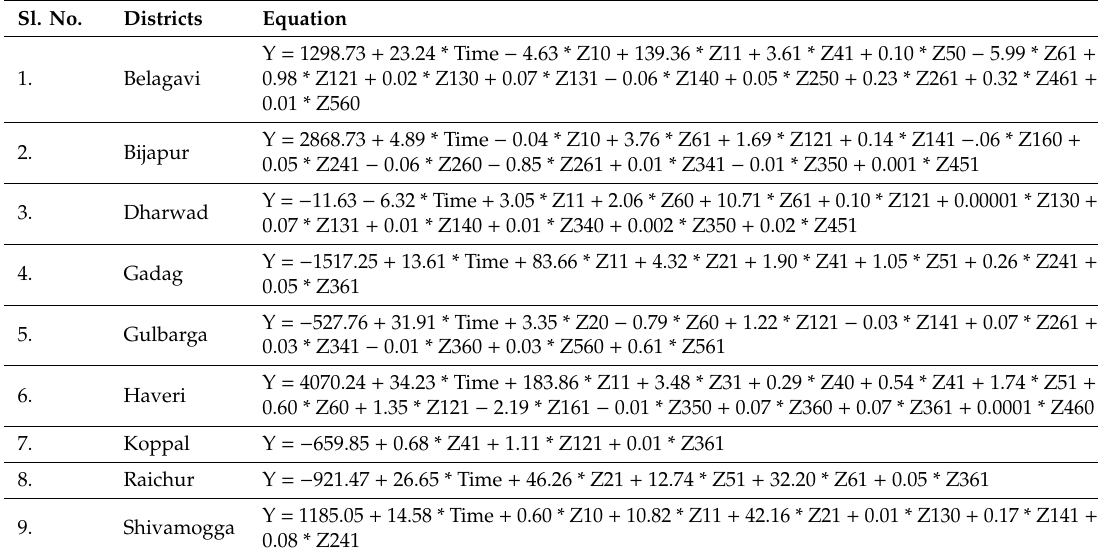
Table A3. Yield predicting equations derived from LASSO for major sorghum growing districts of Karnataka including